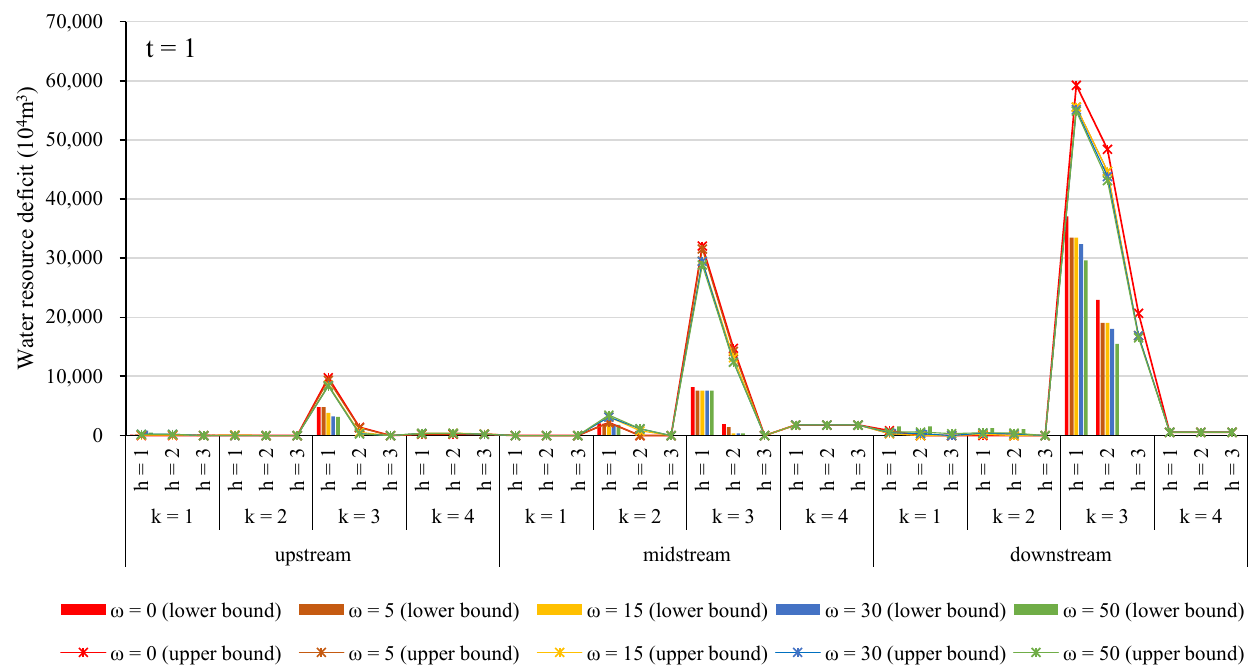
Figure 8. Water resource deficit by region in the Fenhe River Basin in period 1.